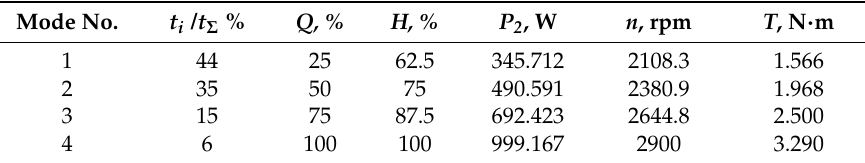
Table 2. Pump and motor load